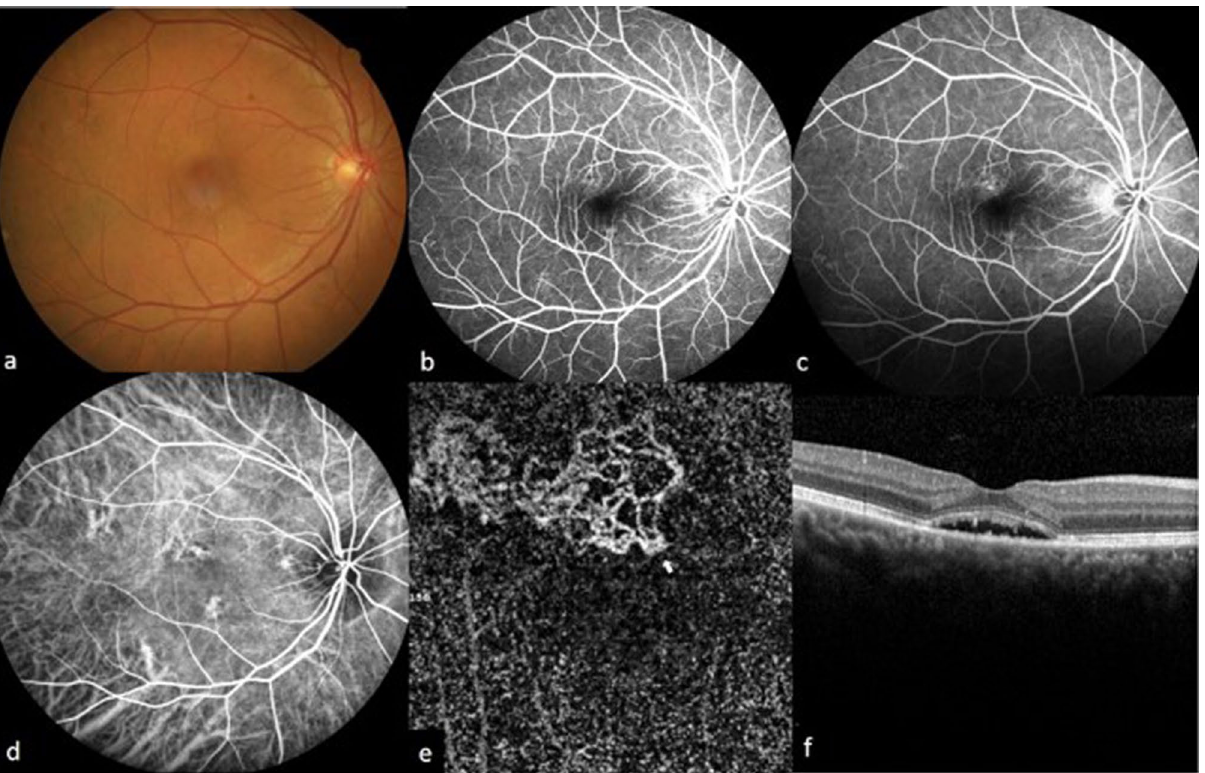
Figure 4. Multimodal imaging of a 54-year old female (case 5) in group 2. The fundus photography shows serous detachment at the macular area ( a ), the hyperfluorescent area demonstrated in early phase ( b )